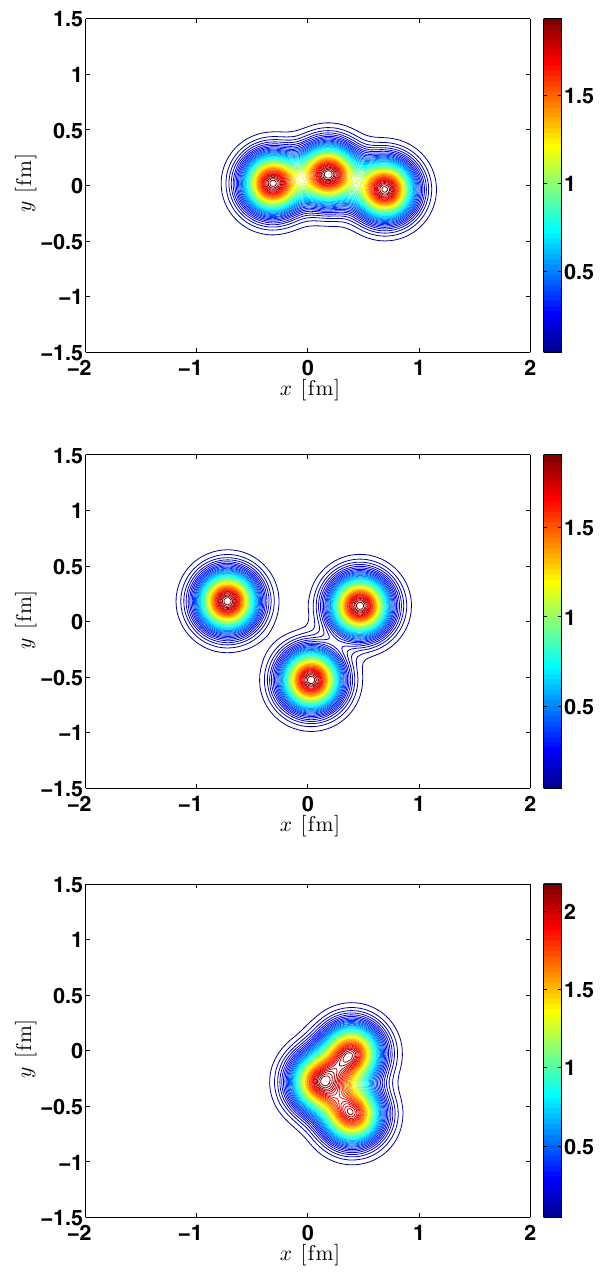
Fig. 6 Examples of density profiles from Eq. (19) with B q = 0 . 7 GeV − 2 characterizing the Gaussian shape of each gluon distribution around the constituent quark